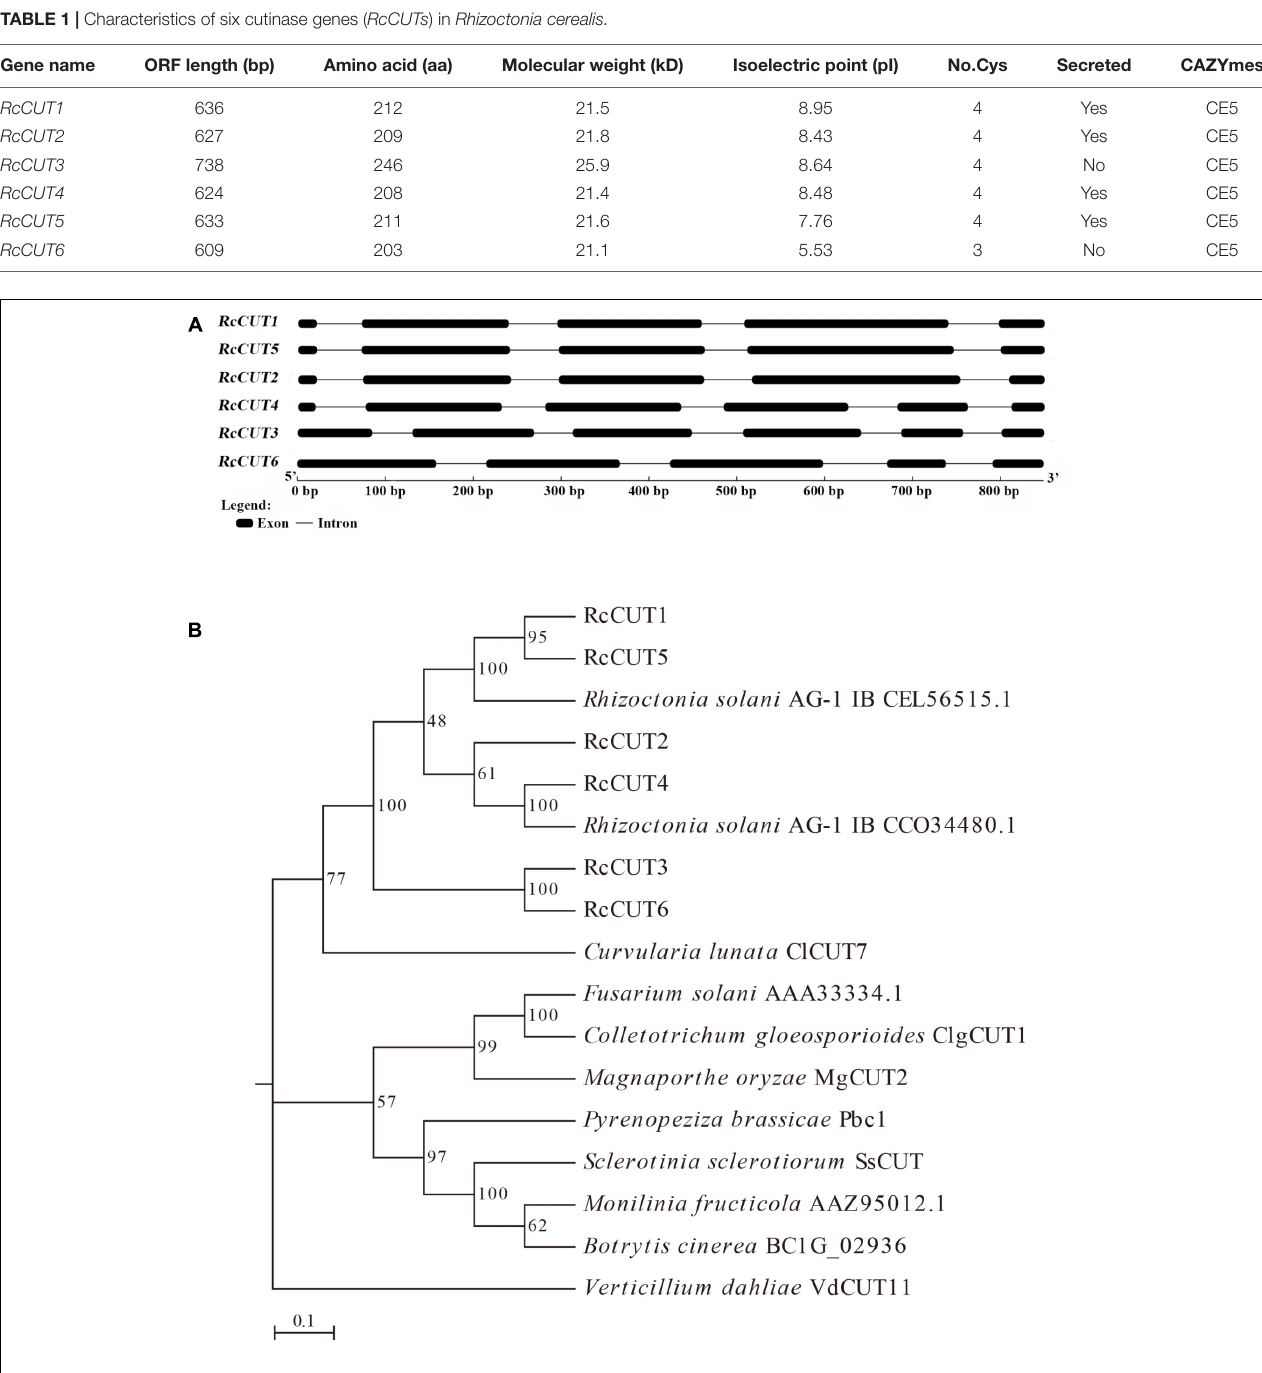
FIGURE 1 | Structures of RcCUT genes in Rhizoctonia cerealis and their phylogenetic relationships. (A) Exons and introns are indicated by black boxes and lines, respectively. The 5 (cid:48) –3 (cid:48) scale indicates the DNA sequence size. The names of the RcCUT genes and intron-exon structures are indicated at the left and right sides, respectively. (B) Phylogenetic relationships between cutinases from R. cerealis and other fungi. The phylogeny was constructed by Mega 7.0 using neighbor-joining method (parameters: 1,000